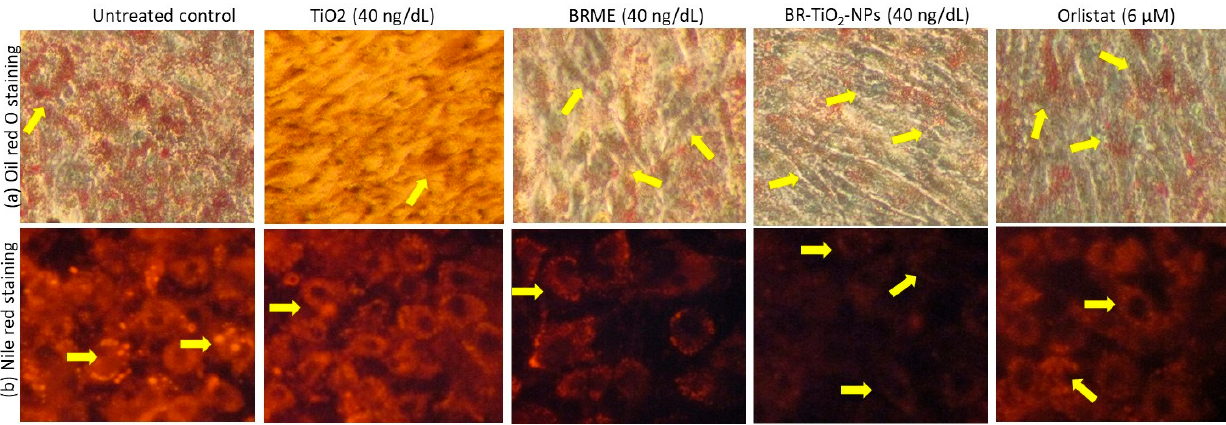
Figure 6. Oil red’O ( a ) and Nile red ( b ) analyses for the lipid accumulation inhibition potential in the untreated maturing adipocytes (control) and adipocytes treated with TiO 2 , BRME, and BR-TiO 2 -NPs for 14 days .